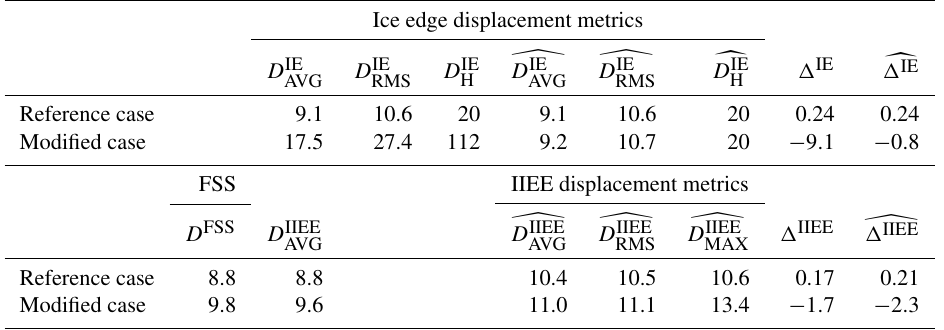
Table 1. Results for the various displacement metrics defined in Sect. 2. Vertical lines are introduced to separate non-negative displacement metrics from signed bias metrics and the FSS metric from IIEE metrics. The reference case and the modified case refer to the observational sea ice concentrations that are displayed in Fig. 3a and b, respectively. All values are given in non-dimensional grid units. Note that in the reference case, all boundaries are considered open, so the ice edge displacement metrics are unaffected when computing the hatted variables. Note also that in the modified case, the bottom boundary was treated as adjacent to a closed (land) boundary.